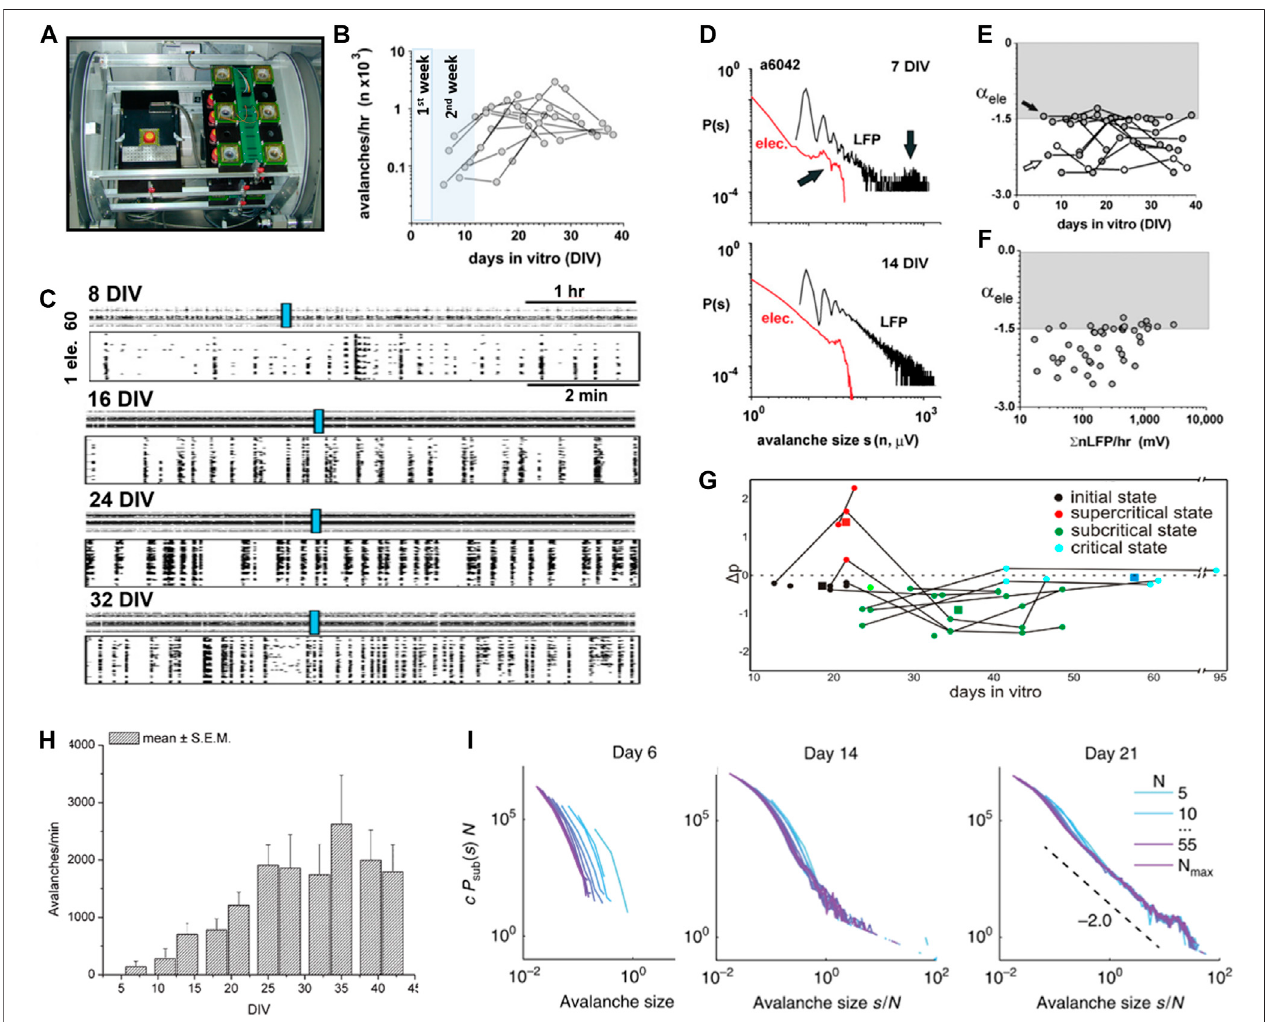
FIGURE 8 | Developmental time course for the self-organization of neuronal avalanches in isolated cortex preparations. (A) Overview picture of a custom-made incubatorforlong-termrecordingsofindividualorganotypiccortexculturesonanMEAinachronic,sterilechamberwithheadstage( left )andoff-recordingstorageracks ( right ). For details, see [166]. (reproduced with permission from [167]). (B) In organotypic cortex cultures, avalanches are absent during the fi rst postnatal week in vitro , butincreaseinrateduringthesecondandthirdpostnatalweeksinlinewith invivo maturationofsuper fi ciallayers. Highlightedperiods :equivalentpostnatalweek in vivo when cultures are taken from pups at postnatal day 1 – 2. (C) Raster plots of spontaneous nLFP increase in complexity from the fi rst to fi fth week ( rows ) postnatally in vitro . Top ofeach row : 5 h raster. Bottom ofeach row : higher temporal resolution for periods indicated bythe blue rectangle . (D) Example ofearly (7 DIV) bimodal size distribution ( top ) and second week power law size distribution ( bottom ) in a single organotypic cortex culture. Sizes are de fi ned as the number of active electrodes ( red )orsummednLFP( black ). (E) Mostorganotypiccortexculturesachieved α (cid:2)− 3/2within2-3 weeks invitro ( arrow ),exceptforone( opencircle ).Timecoursein avalanche size distribution slope α for individual organotypic cortex cultures. (F) The emergence of slope α (cid:2) − 3/2 correlates with a ∼ 10x increase in LFP activity. ( B – F modi fi ed and reproduced with permission from [94]). (G) In dissociated cultures taken at PND 0 - 1, power laws tend to be reported after ∼ 4 weeks in culture (reproduced under CC-NY license from [98]). (H) Neuronal activity reaches a steady state in dissociated cortex cultures after ∼ 4 weeks in vitro (reproduced with permission from [107]). (I) Transition of avalanche size distributions from exponential to bimodal in dissociated cortex cultures (reproduced under CC-NY license from